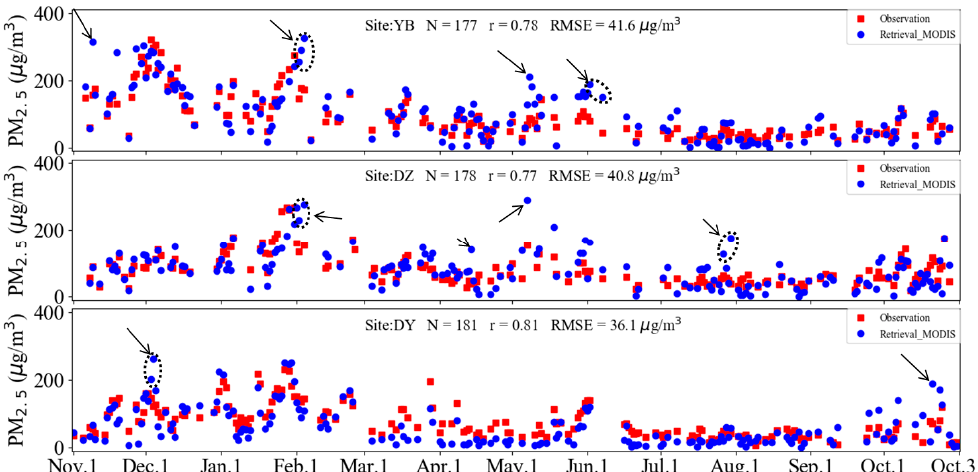
Figure 12. Time series evaluation of retrieved ground-level PM 2.5 with surface measurements at the sites of Yibin, Dazhou, and Deyang during 1 November 2013 to 31 October 2014. The annual mean MODIS retrieved PM 2.5 concentration at all three sites (80.80 (mean) ± 50.68 (standard deviation) μ g/m 3 ) is approximately 2.61% lower than the ground-based measurements (82.96 (mean) ± 55.63 (standard deviation) μ g/m 3 ) with a similar variation dynamic range. A similar study by Liu [66] found that the annual average MISR retrieved PM 2.5 concentration at the 17.6 km resolution over the United States is approximately 10% lower than the surface measurements reported by EPA so that using AOD data at higher resolutions is suggested to improve the retrieval accuracies. The MODIS retrieved PM 2.5 concentration are generally higher than the ground-based measurements in YB (7.28%) and DZ (1.05%) which located in eastern Sichuan Basin, but lower in the western part, such as DY (6.69%). A scatterplot in Figure 13 illustrated that annual average MODIS retrieved PM 2.5 concentrations have a good linear relationship with ground-based measurements ( r = 0.78, linear regression slope = 0.7493). Good agreements are shown with r = 0.78 ( N = 538) for PM 2.5 throughout the whole year and r = 0.77, 0.80, 0.79 and 0.76 in spring, summer, autumn and winter, respectively. More dust storms and biomass burning occur in spring and winter could result in larger variations in aerosol types, which could decrease the correlation coefficient [65].